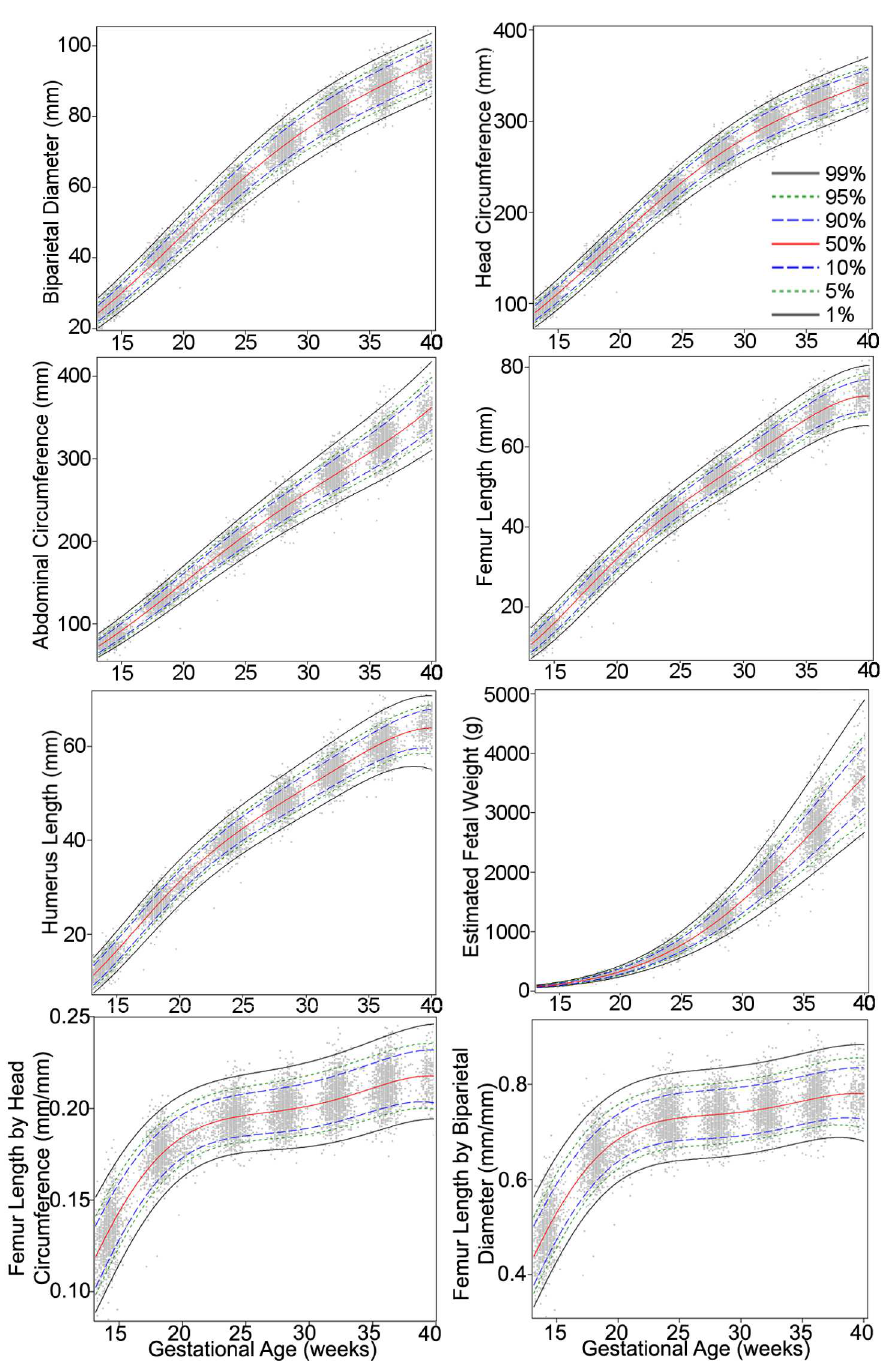
Fig 1. Percentiles for biparietal (outer–inner) diameter, head circumference, abdominal circumference, femur length, humerus length, estimated fetal weight, femur length/head circumference ratio, and femur length/biparietal diameter ratio during gestational weeks 14–40. The percentiles (percent) 1st, 5th, 10th, 50th, 90th, 95th, and 99th (smoothed lines)are basedon quantileregression and are shown with the observedvalues(grey